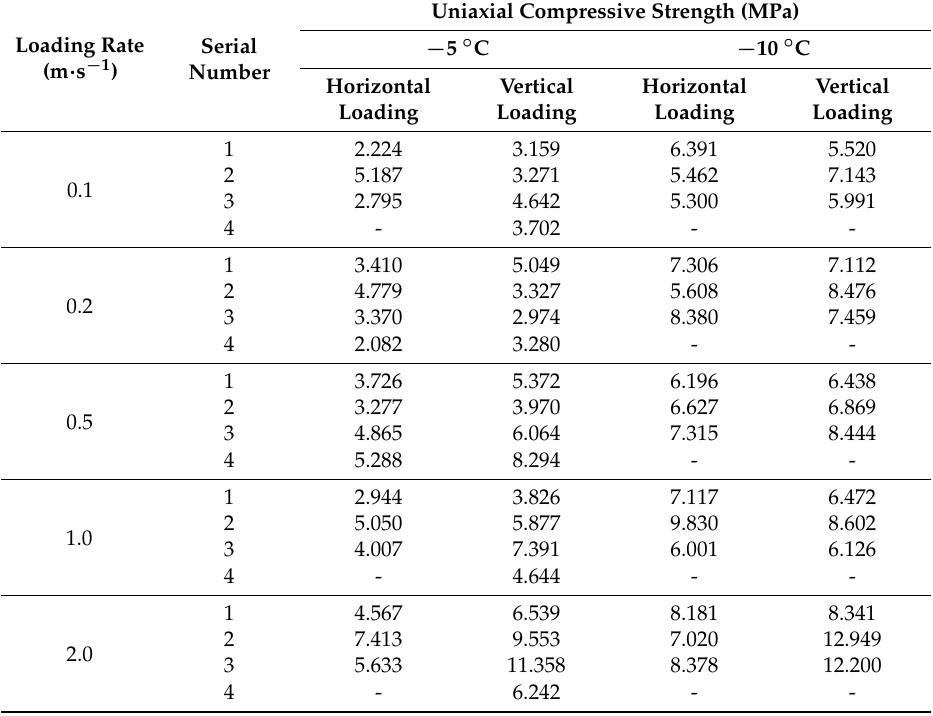
- denotes failed samples.